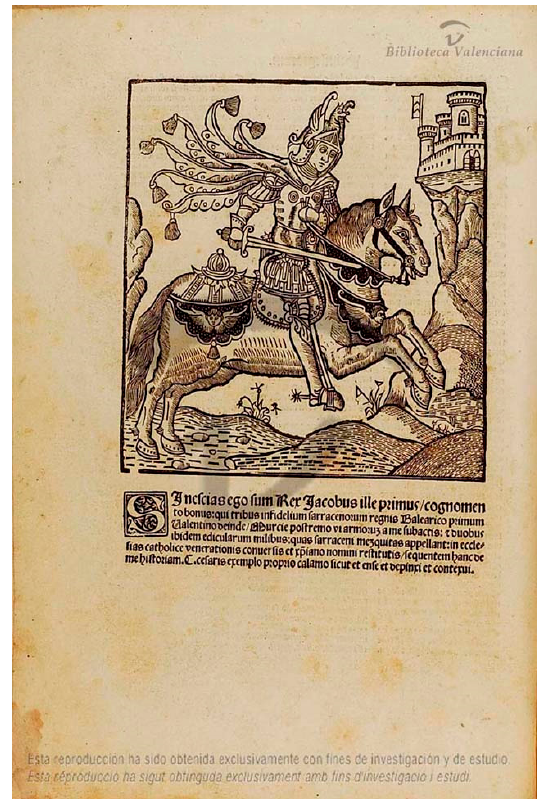
Figure 11. King James I in Lluís Alanyà, Aureum Opus regalium privilegiorum civitatis et regni Valentie cum historia christianissimi regis Jacobi ipsius primi conquistatoris, Valencia, 1515, f. 6v (Valencia, Biblioteca Valenciana). Used by